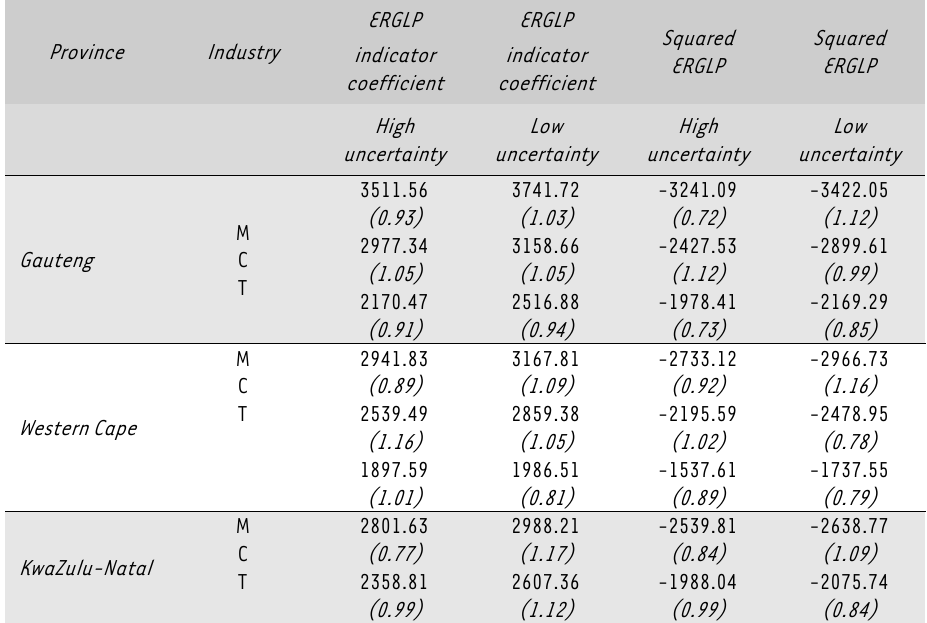
ERGLP indicator coefficients for the different industries and geographical areas in a low or high uncertain business